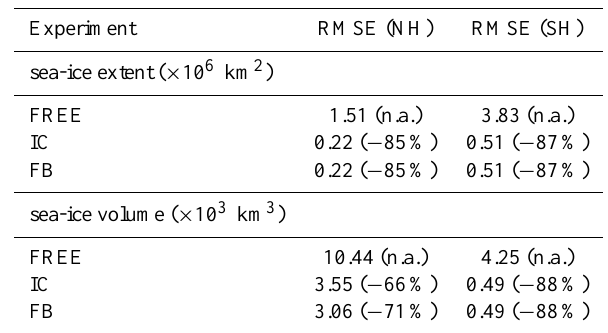
Table 3. Root mean squared error (RMSE) of sea-ice extent and volume between data assimilation experiments using the synthetic data and the synthetic observations themselves in the NH and SH, respectively, from the begining of October and February (end of the adjustment phase) to the end of the simulation. Within parentheses are the reductions of RMSE for each simulation (compared to the FREE simulation).